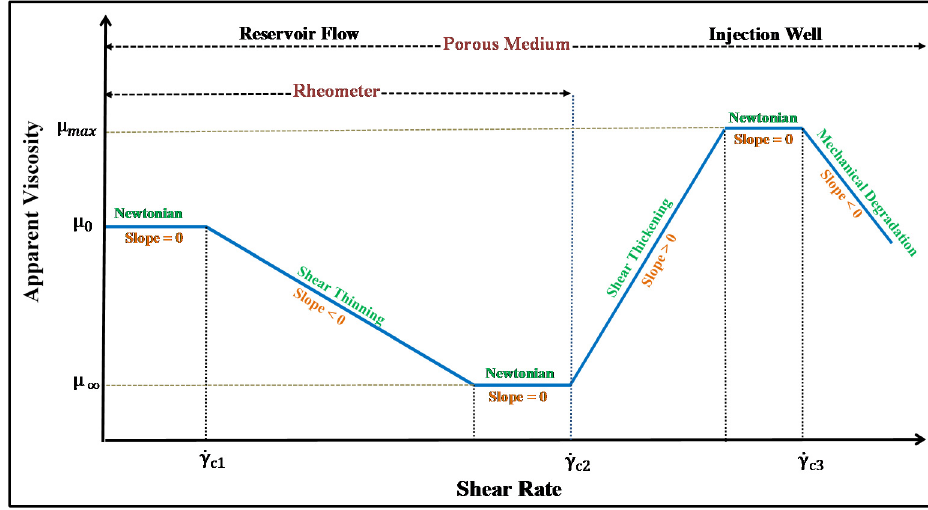
Figure 1 Schematic diagram of HPAM apparent viscosity vs shear rate. Figure 1. Schematic diagram of HPAM apparent viscosity vs shear